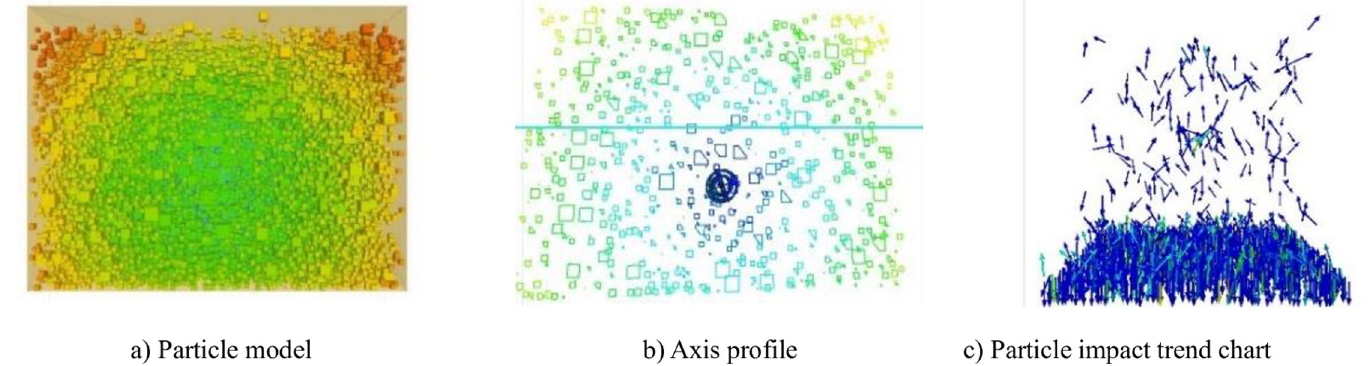
Fig 3. Numerical simulation model. a) Particle model, b) Axis profile, c) Particle impact trend chart.